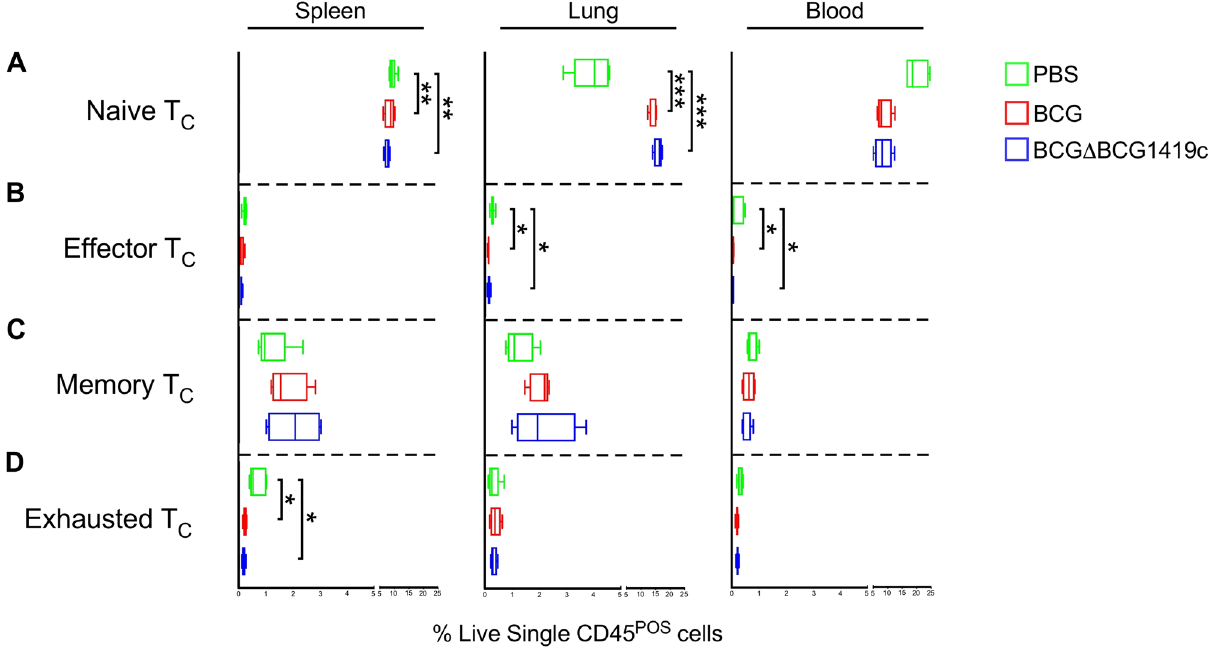
Figure 6. CD8 + T cell subset frequencies in BCG- and BCGΔBCG1419c-immunized mice. CD8 T cell (T C ) subset frequencies in BCG- and BCGΔBCG1419c-immunized mice, as well as PBS controls, were measured in the spleen, lung and blood, based on their expression of CD62L and CD44 (naïve, CD62L HI CD44 LO ; effector, CD62L LO CD44 HI ; memory, CD62L HI CD44 HI ; exhausted, PD1 + ). Shown are the frequencies of ( A ) naïve T C cells, ( B ) effector T C cells, ( C ) memory T C cells and ( D ) exhausted T C cells in the spleen (left column), lung (middle column) and blood (right column), as gated off of live single CD45 + cells. Boxes represent data from 3 mice per group; asterisks represent a statistically significant difference between indicated rows (*p ≤ 0.05; **p ≤ 0.005; ***p ≤